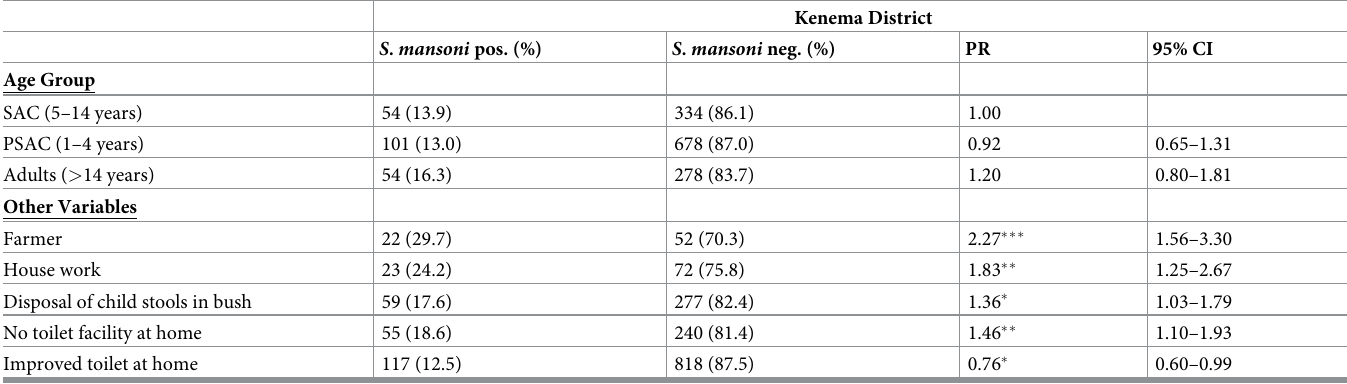
Table 4. Distribution of S . mansoni cases and crude prevalence ratios for variables independently associated with infection, Kenema district.